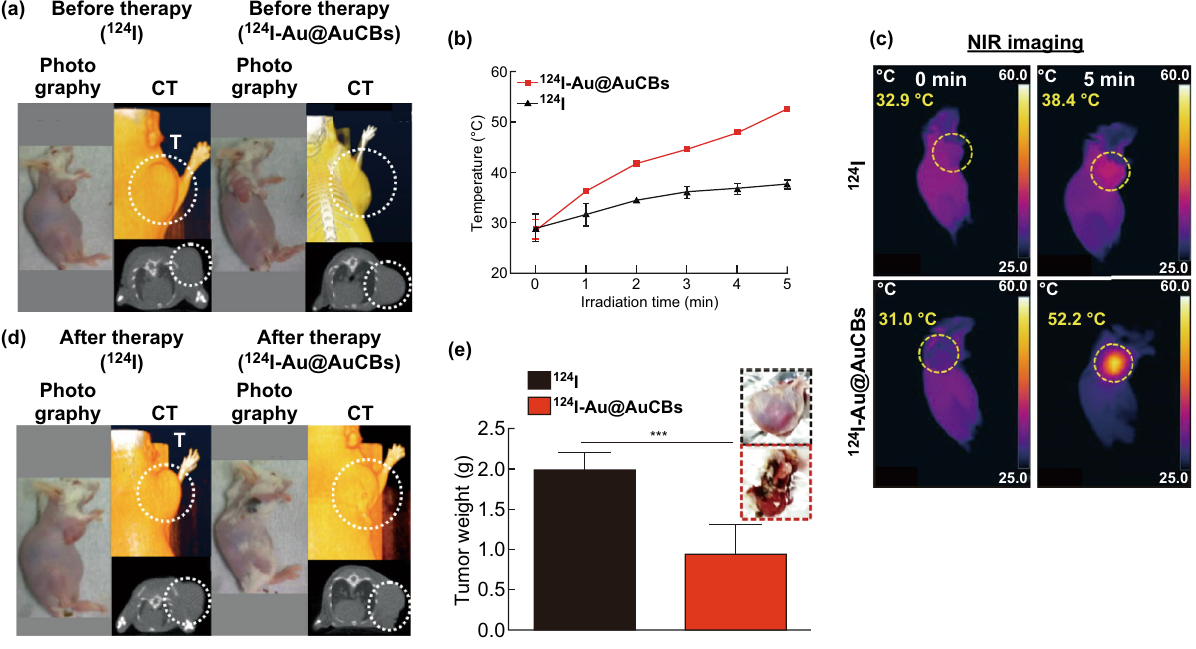
Fig. 4 Evaluation of the effects of photothermal therapy with 124 I‑Au@AuCBs in CT26 tumor‑bearing mice. a , d Photograph and computed tomo‑ graphic imaging of CT26 tumor‑bearing mice, before and after PTT with 124 I‑Au@AuCBs. CT26 tumor‑bearing mice were administered either 124 I or 124 I‑Au@AuCBs, and tumors were exposed to an NIR laser irradiation. b Temperature changes in either free 124 I‑or 124 I‑Au@AuCB‑injected CT26 tumors after irradiation with an NIR laser (9 W cm −2 , 5 min). c NIR imaging of CT26 tumor‑bearing mice, before and after irradiation with an NIR laser. e Measurement of tumor weight after photothermal therapy. Inset: upper, CT26 tumors with 124 I and NIR laser treatment; bottom, CT26 tumors with 124 I‑Au@AuCBs and NIR laser treatment. In vivo experiments were performed in duplicate ( n = 7 mice per group). ***P <